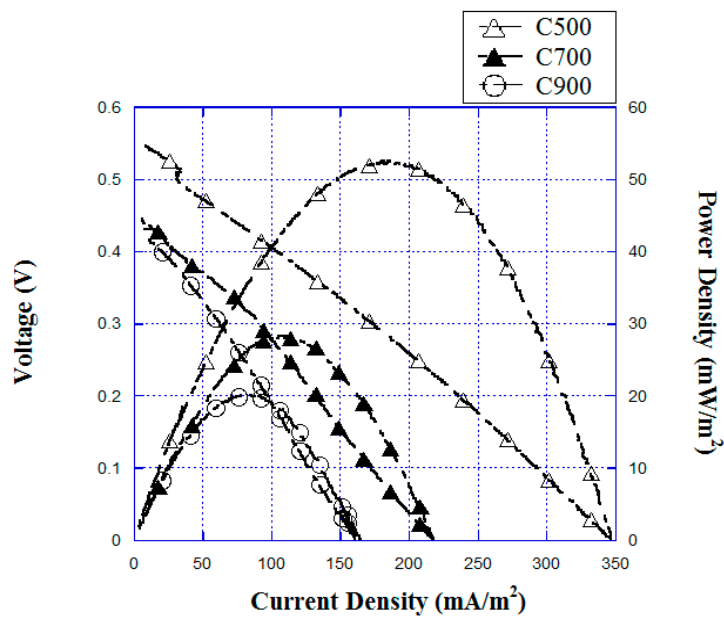
Figure 3. Polarization and power density curves of BEF-MFC at different calcination temperatures of Fe 2 O 3 .